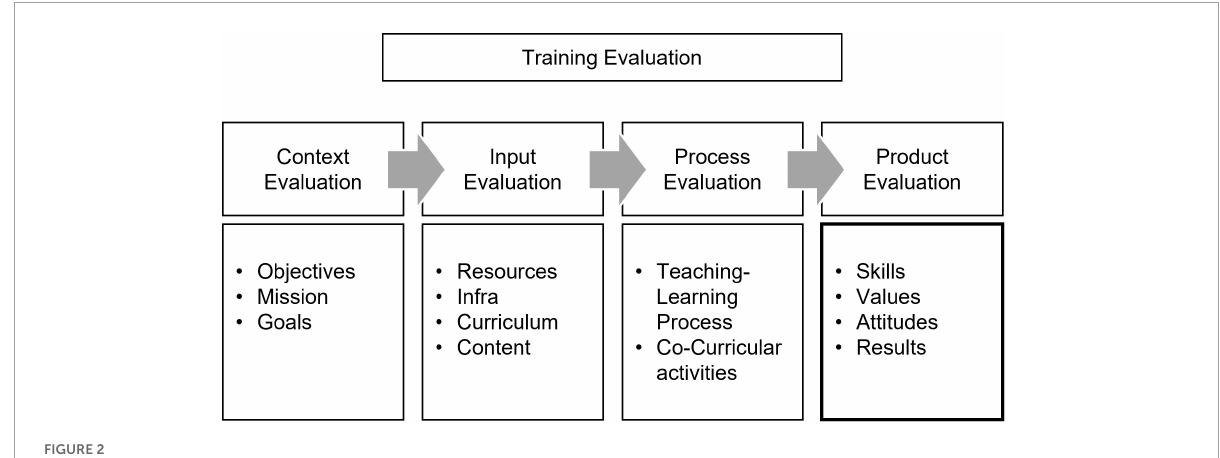
FIGURE2 CIPP evaluation